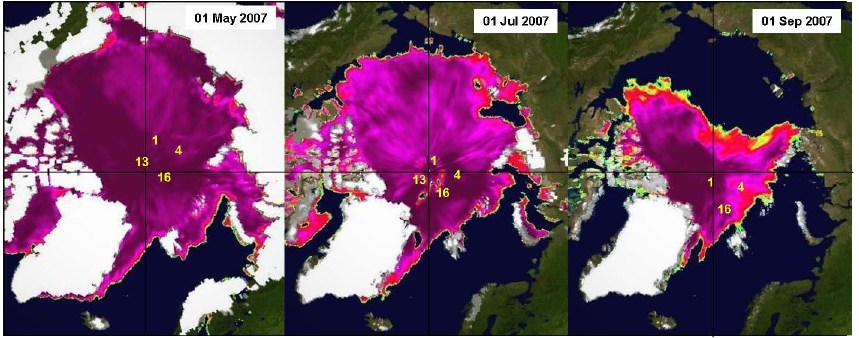
Fig. 3. Ice extent and concentration on 1 May, 1 July, and 1 September 2007 (from The Cryosphere Today; http://arctic.atmos.uiuc.edu/ cryosphere/) together with location of the four corner buoys 1, 4, 13, and 16 of the D07 buoy